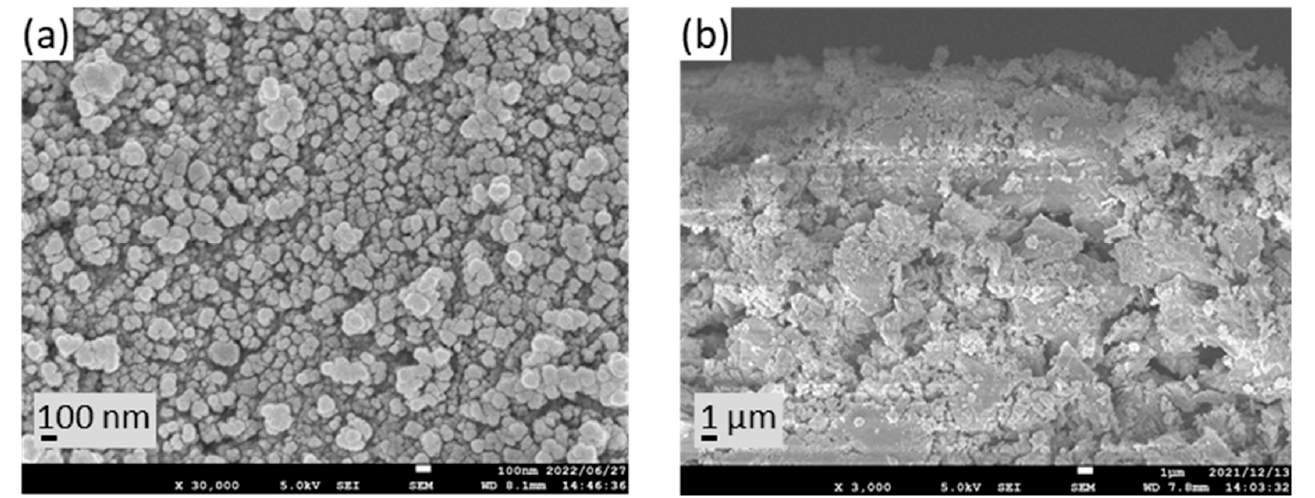
Figure 3. TiO 2 membrane morphology: ( a ) surface view, ( b ) cross-sectional view.